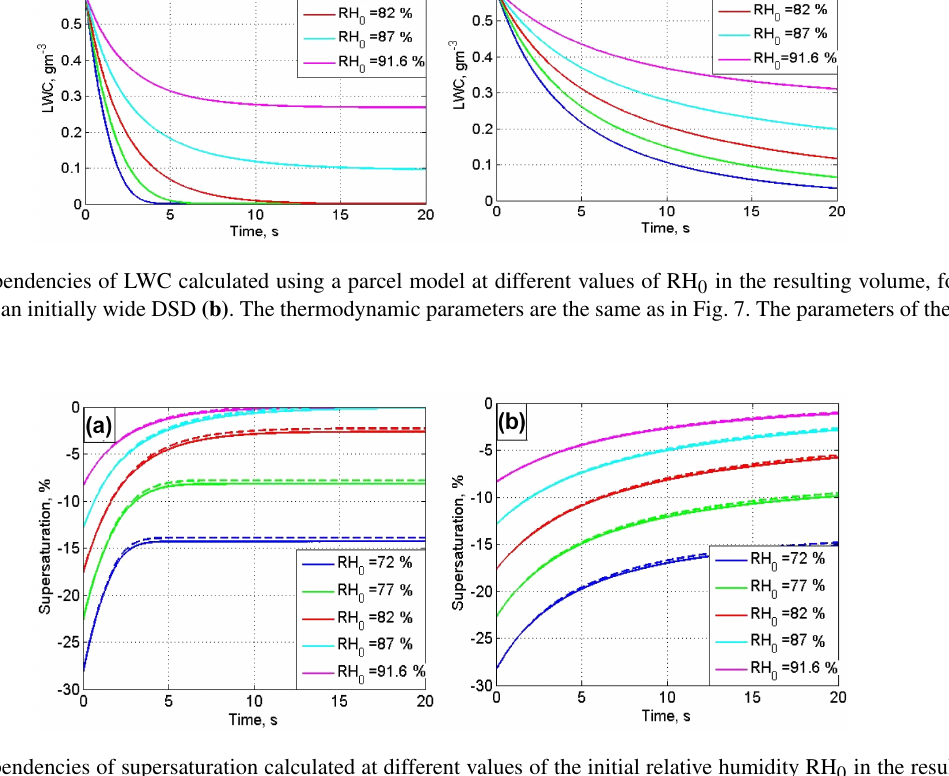
Figure 12. Time dependencies of supersaturation calculated at different values of the initial relative humidity RH 0 in the resulting volume, using Eq. (8) (solid lines) and Eq. (40) (dashed lines), for an initially narrow DSD (a) and an initially wide DSD (b) . The thermodynamic parameters are the same as in Fig. 7. The parameters of the initial DSDs are given in Table